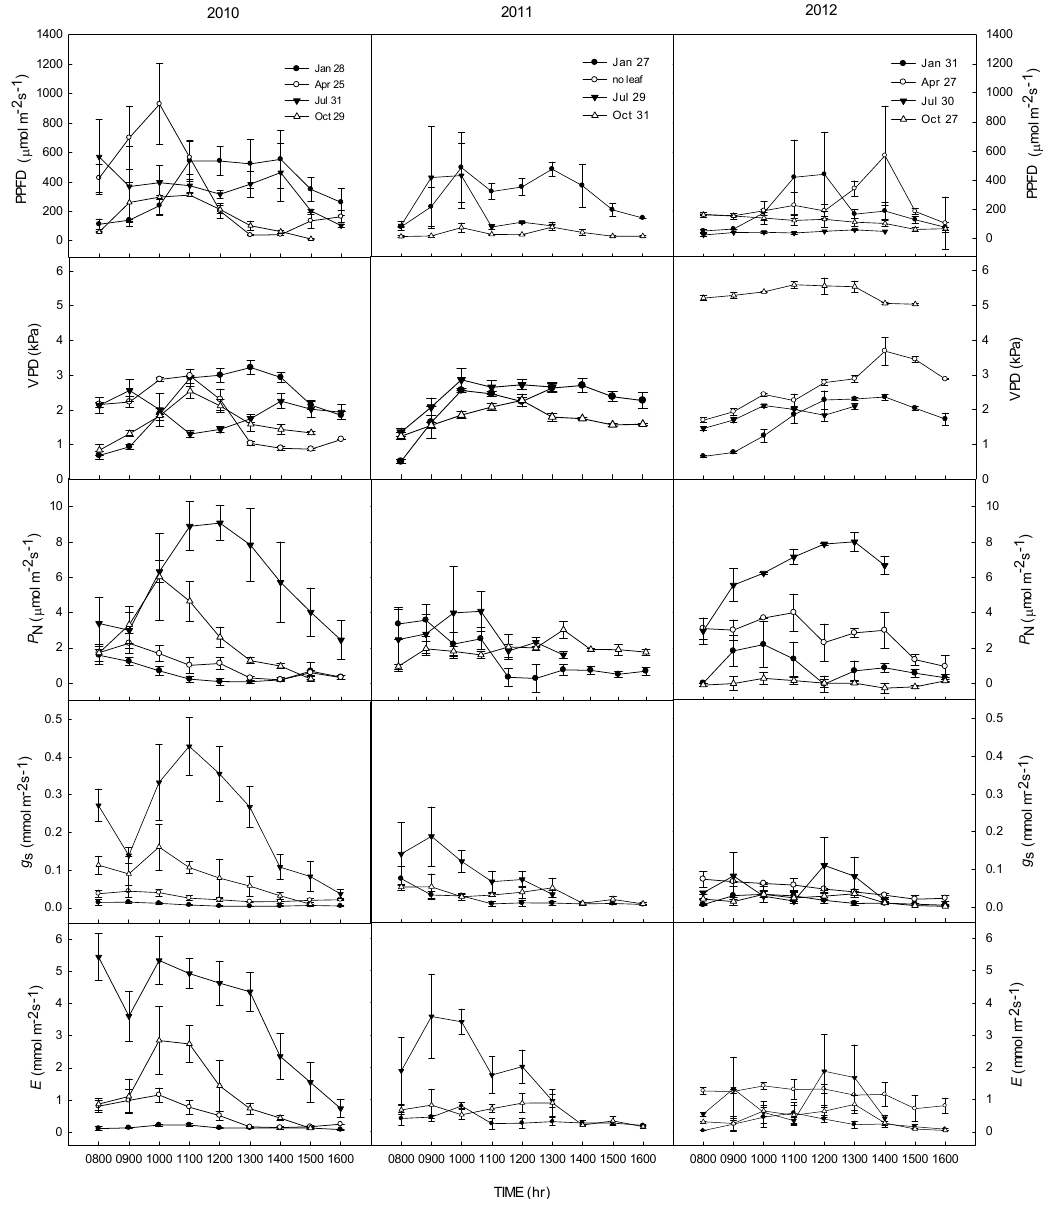
Figure 2. Diurnal changes in light intensity (PPFD), vapor pressure deficit (VPD), net photosynthetic rate ( P N ), stomatal conductance ( g s ), and transpiration rate ( E ) of Fraxinus griffithii across different seasons from 2010 to 2012. The data gap in 2011 and 2012 occurred due to full defoliation in April 2011 and thunderstorms in July of both years. Bars indicate ± standard error.